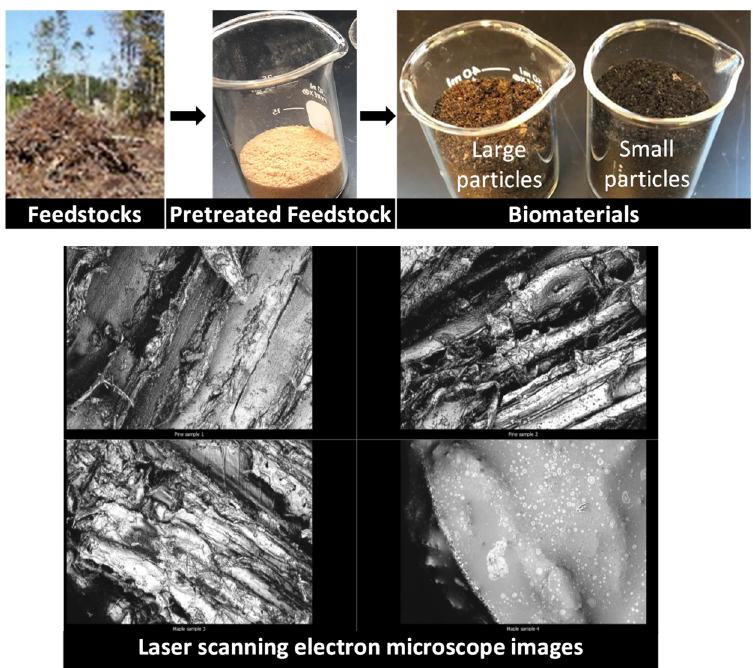
Figure 2. Mixed fast and slow pyrolysis process.